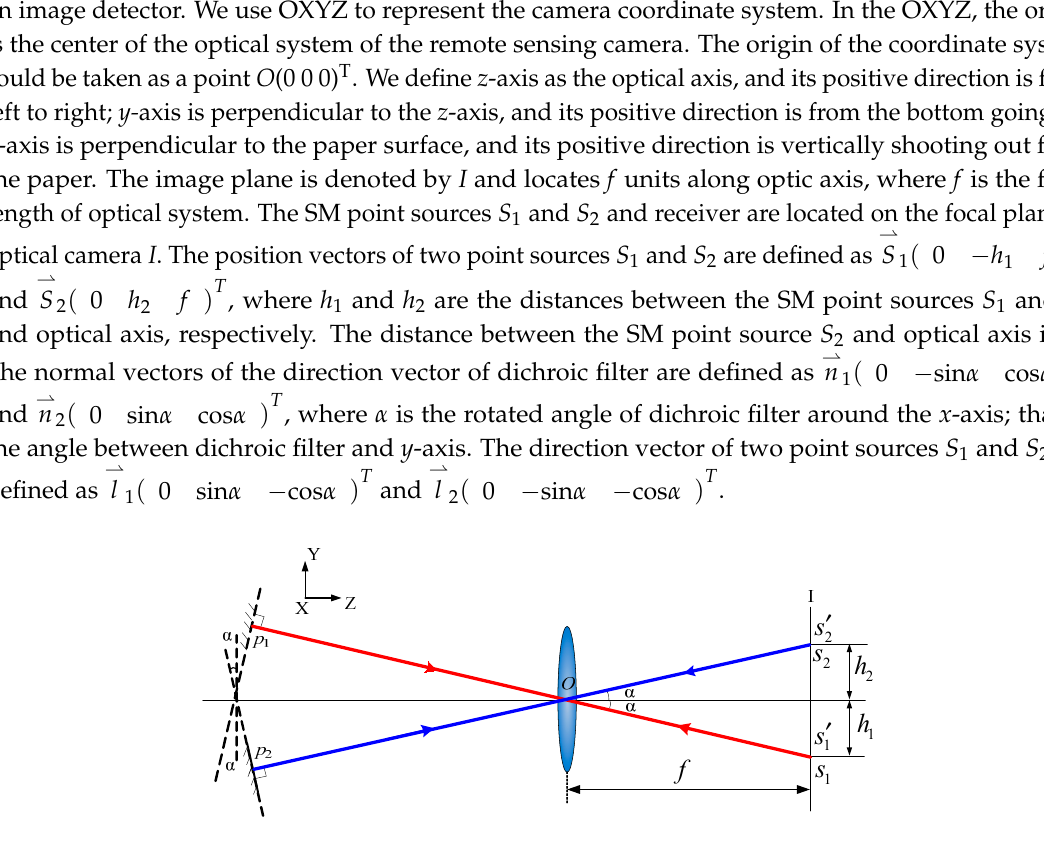
Figure 6. Imaging relationship of an ideal optical system.